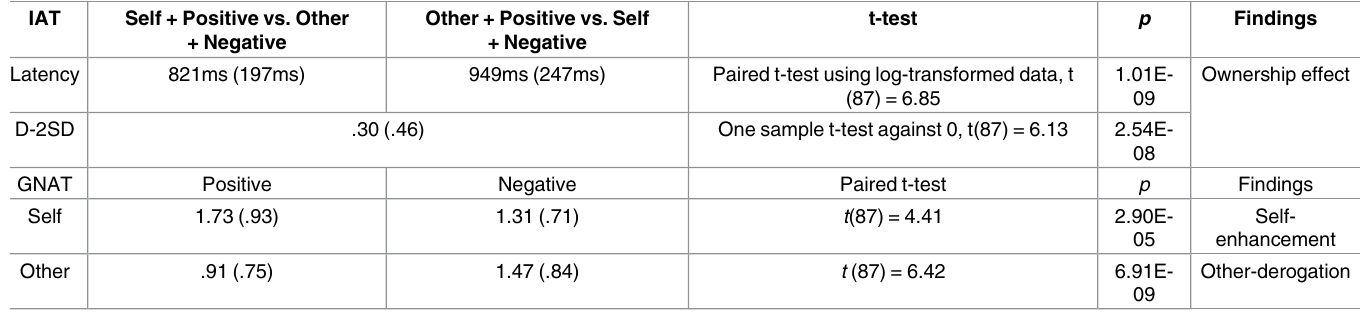
Table 3. Result Summary of the IAT and the GNAT. IAT Self + Positive vs. Other +